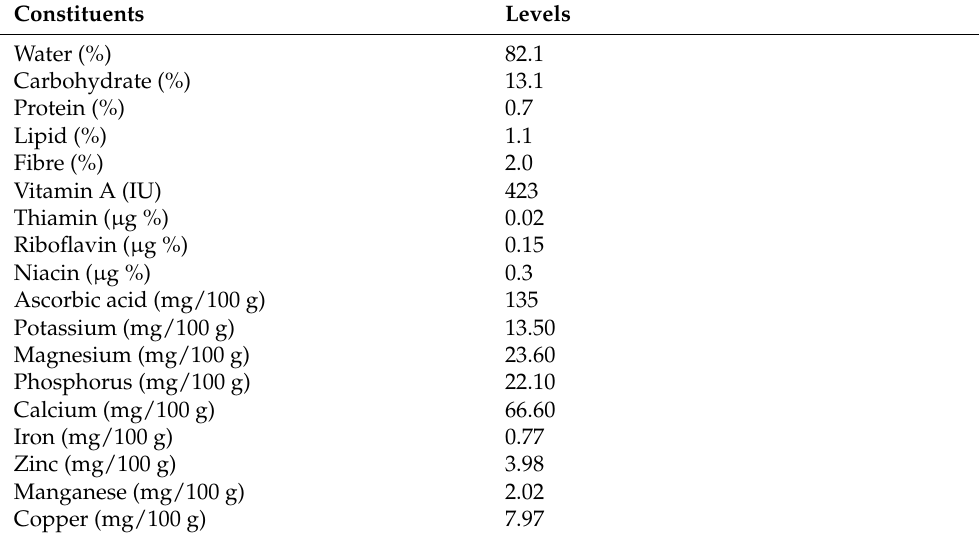
Table 1. The nutritional content of A. lacucha